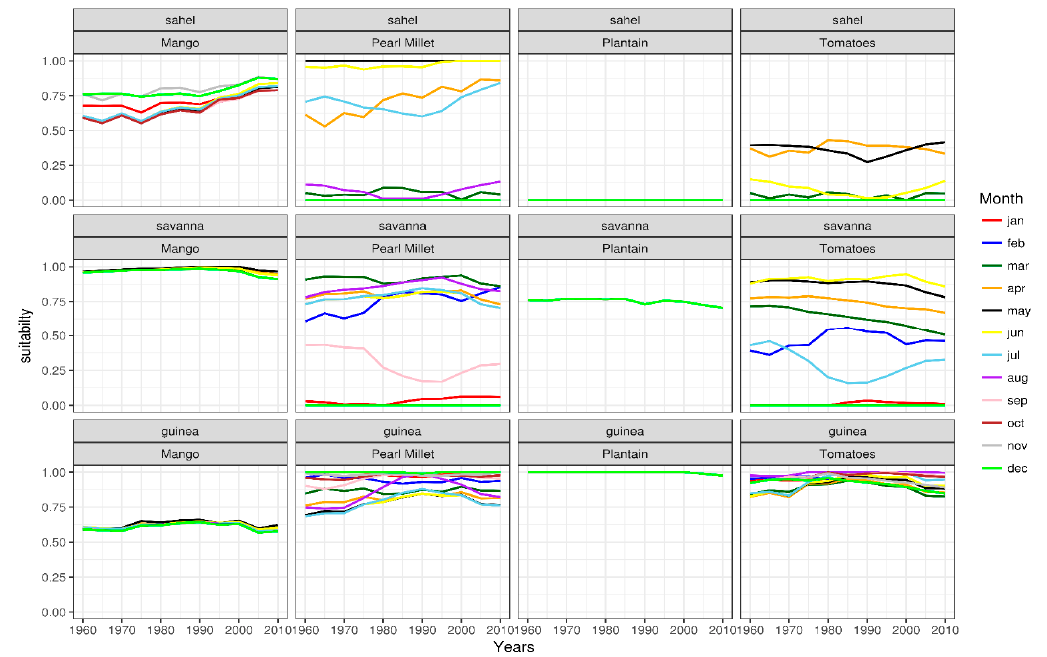
Figure 8. Ensemble crop suitability plots in the past climate (1960–2010) for mango, pearl millet, plantain, and tomatoes.